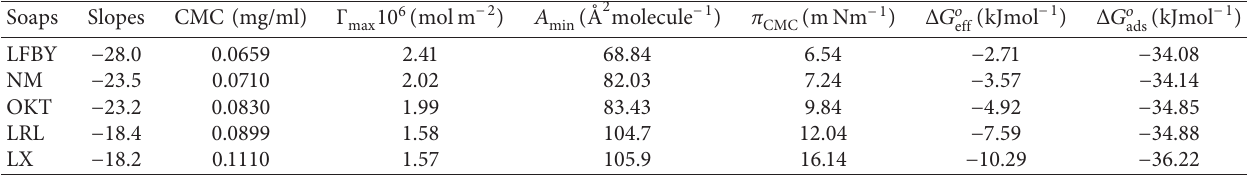
), the area occupied by surfactant max